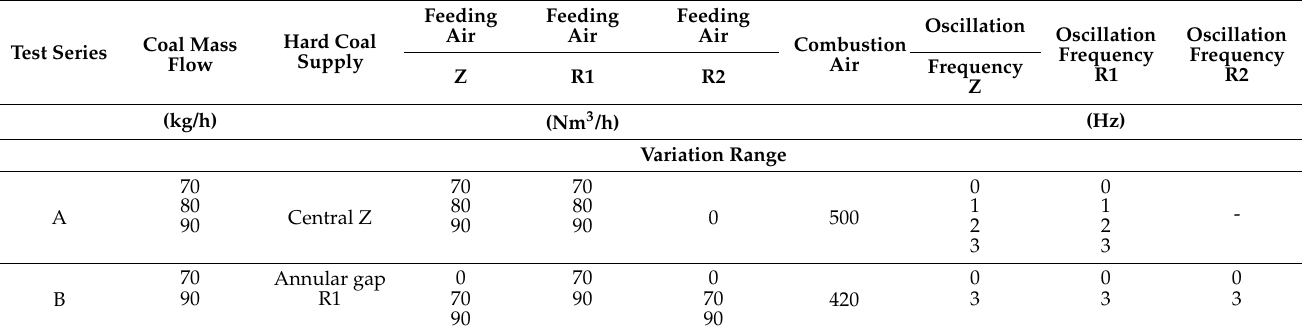
Table 1. Experimental